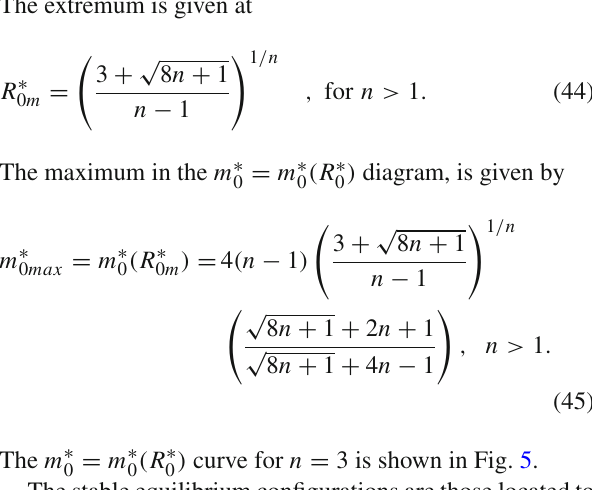
Fig. 5 m ∗ EOS III with n = 3